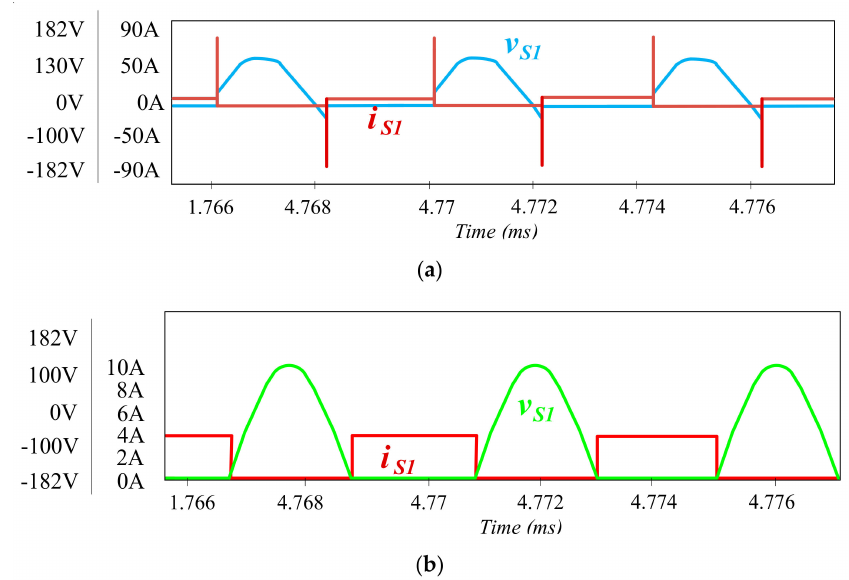
Figure 8. Signals: ( a ) current and voltage on S 1 with a non-overlapped control, ( b ) current and voltage on S 1 with an overlapped control.